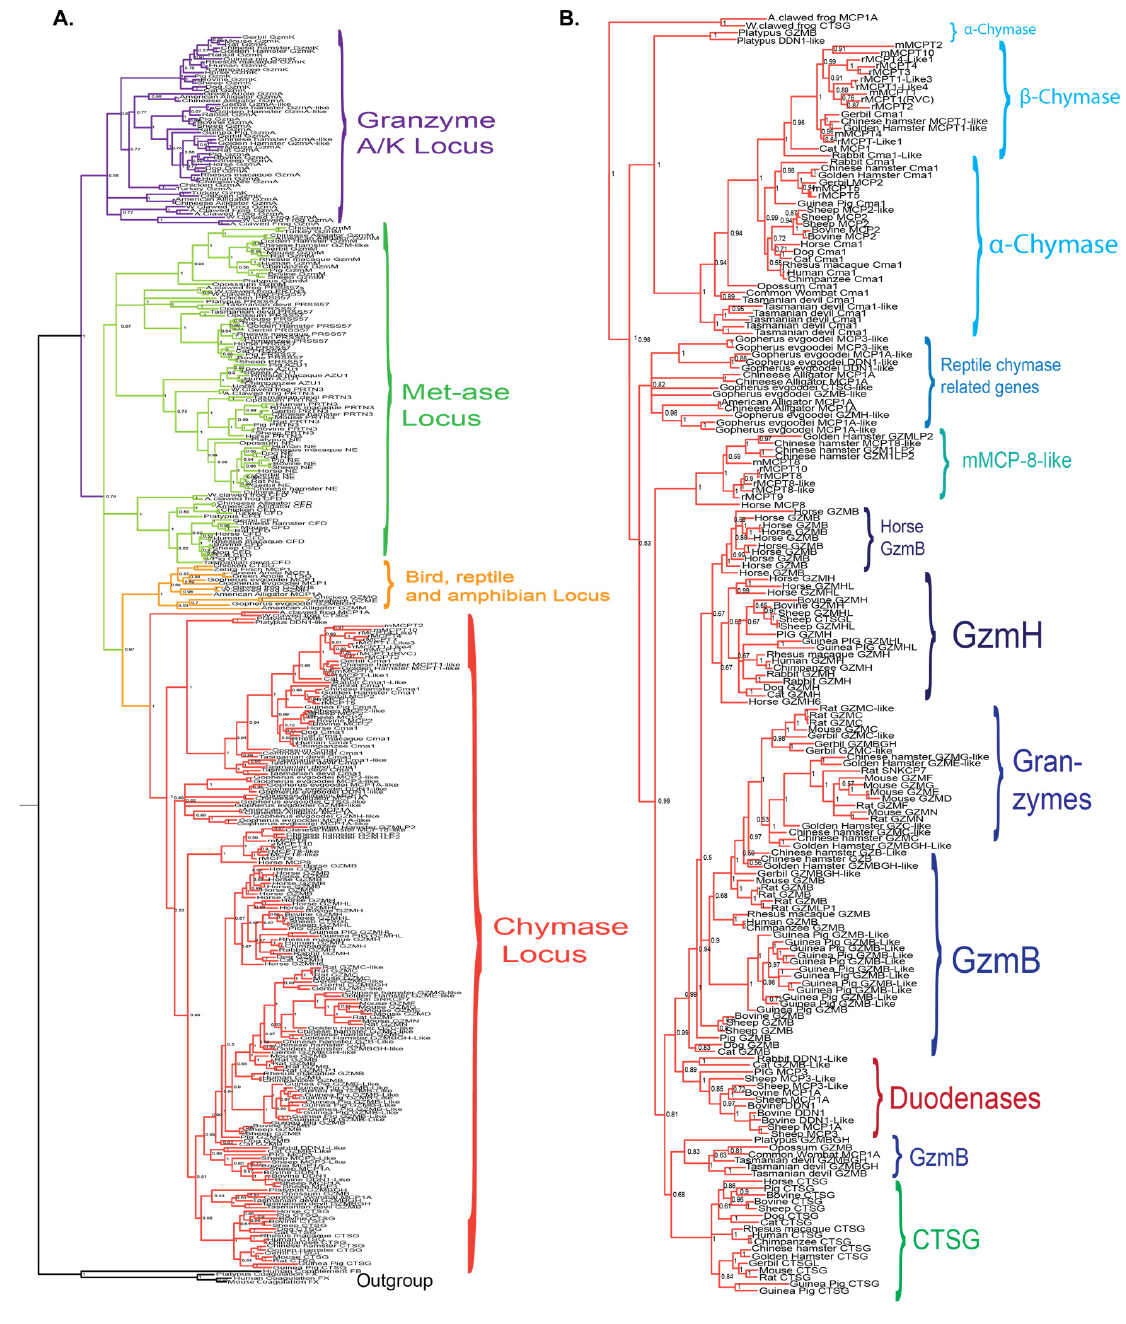
Figure 9. Phylogenetic analysis of a panel of hematopoietic serine proteases with the focus on chymase-locus -encoded genes. The amino acid sequences of the active protease, lacking a signal sequence and activation peptide, was analyzed using the MrBayes computer program to generate the phylogenetic tree. The resulting values were then transferred to the FigTree program to generating a tree suitable for figure generation. The results were finally transferred to Adobe illustrator for refining of the figure and the addition of explanatory text and decorations. The different branches of the tree have been color-coded for a clearer visualization of individual branches. A few non-hematopoietic serine proteases, pancreatic trypsin and blood coagulation enzymes, were included as outgroups to help form a more stable tree. ( A ) shows a tree including proteases from four different loci to put the chymase locus in the context of the other loci encoding hematopoietic serine proteases. ( B ) shows an enlarged picture of the chymase locus genes of panel A to be able to see the names of the individual genes.